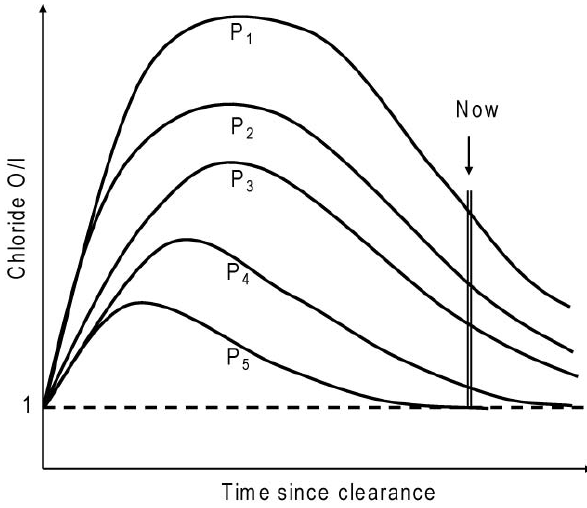
Fig. 5. Conceptualized evolution paths of type VI catchments start- ing from the forest clearance to type II catchments as a function of climate conditions, where P i is mean annual precipitation; it in- creases from P 1 to P 5 (extended from Fig. 2 in Jolly et al., 2001).